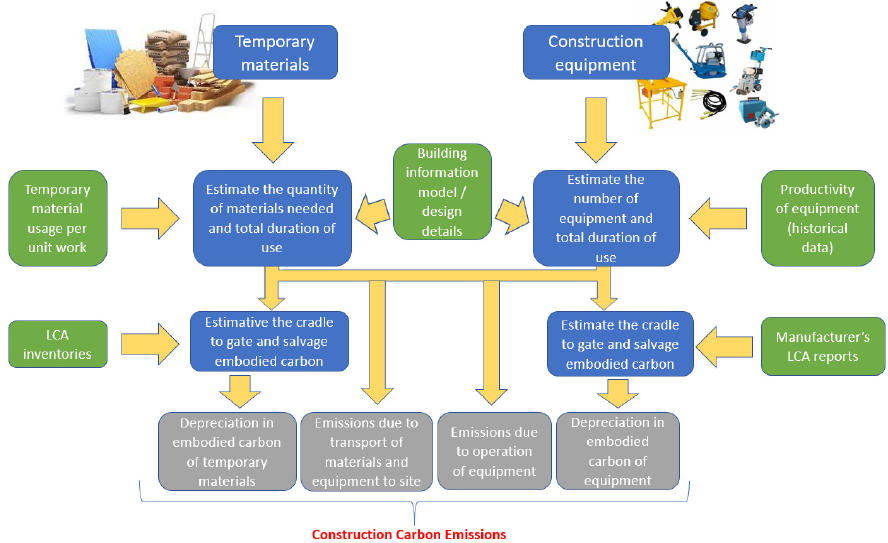
Figure 2. A framework for the estimation of carbon emissions incurred during the construction phase [26–28].